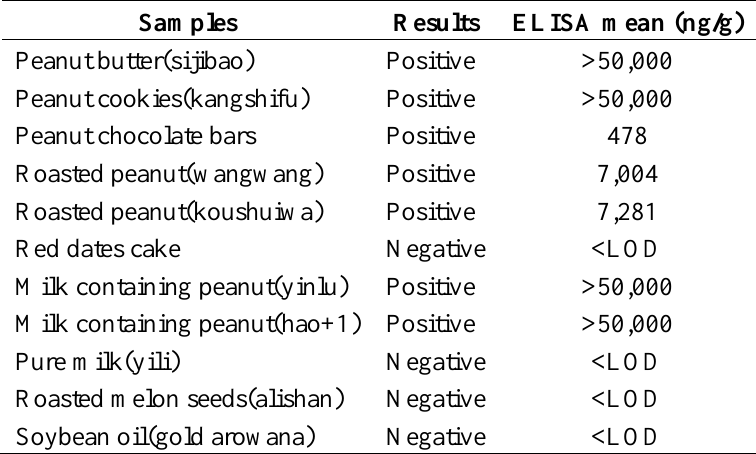
Table 3. Detection of Arah1 in the commercial foods.